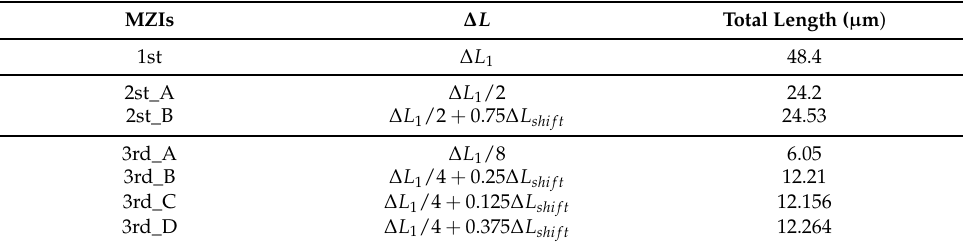
Table 2. Parameters for the calculation of the delay line